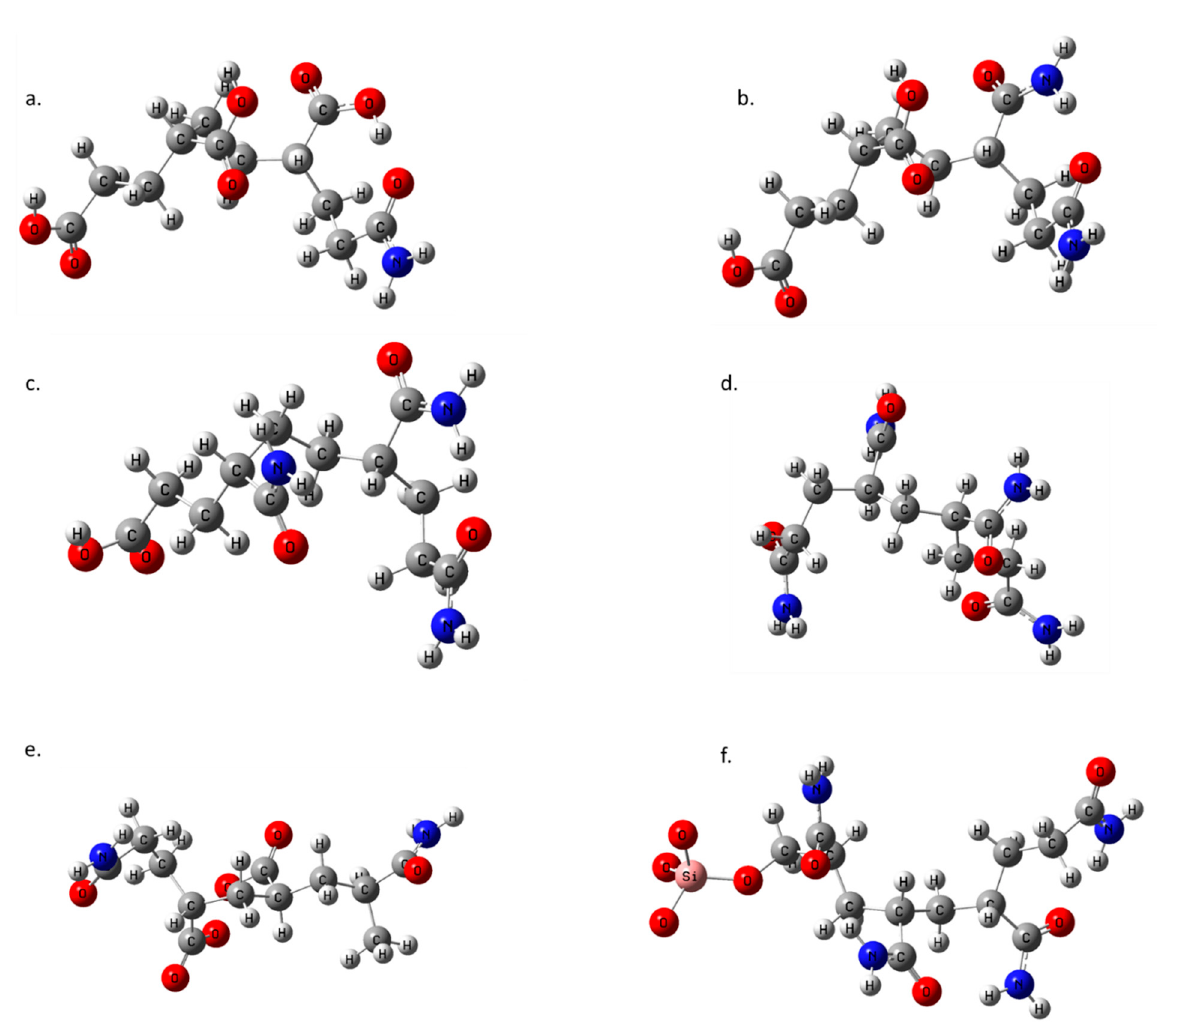
Figure 1. The optimized structures of ( a ) AA ‐ AA ‐ AA ‐ AM (70% ‐ Acrylic Acid), ( b ) AA ‐ AA ‐ AM ‐ AM (50% each of acryl acid and acryl amide), ( c ) AA ‐ AM ‐ AM ‐ AM (70% acryl amide), ( d ) PAM, ( e ) AM (50% each of acryl acid and acryl amide), ( c ) AA-AM-AM-AM (70% acryl amide), ( d ) PAM, PAM_hydrolyzed, and ( f ) PAM ‐ Silica. ( e ) PAM_hydrolyzed, and ( f )